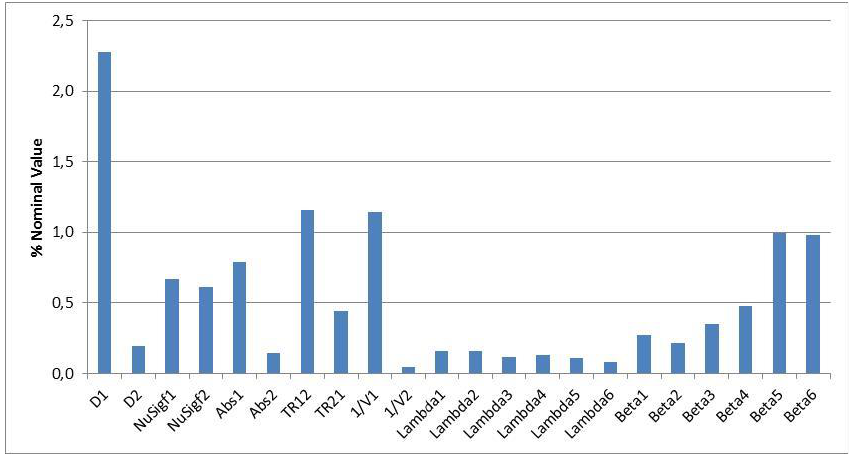
Figure 2: Cross Sections Standard Deviation at 18 GWd/tHM (see